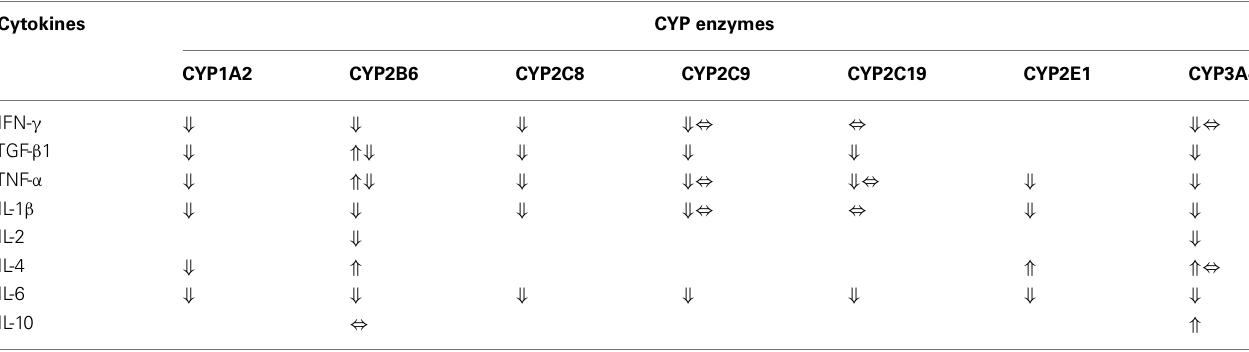
Table 1 | Effects of various cytokines on individual drug metabolizing CYP enzyme expression (mRNA or protein) and activity in vitro (no available data for